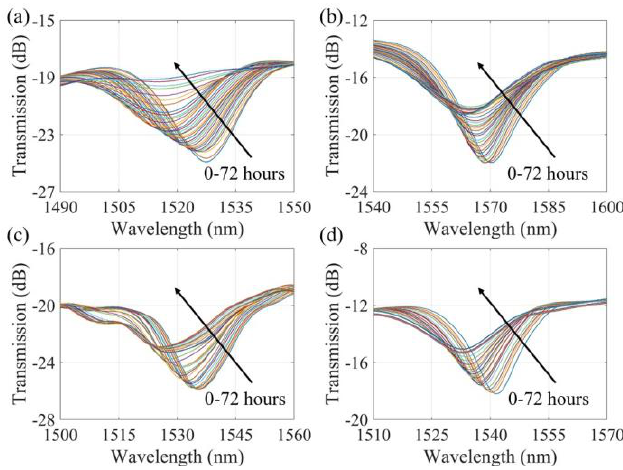
to 42, 36 and 28 hours, respectively. This is because the strain-induced cracks in the Fe-C layer